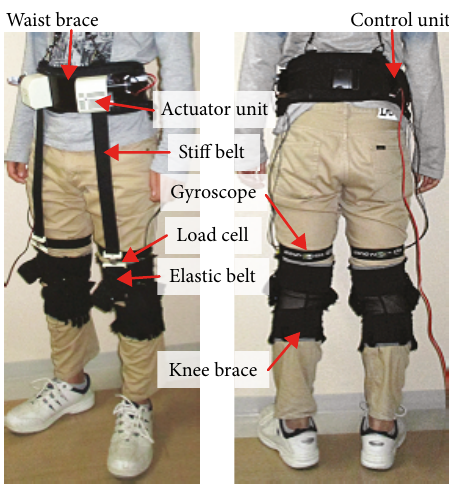
Figure 1: Overall structure of a soft wearable robotic suit.